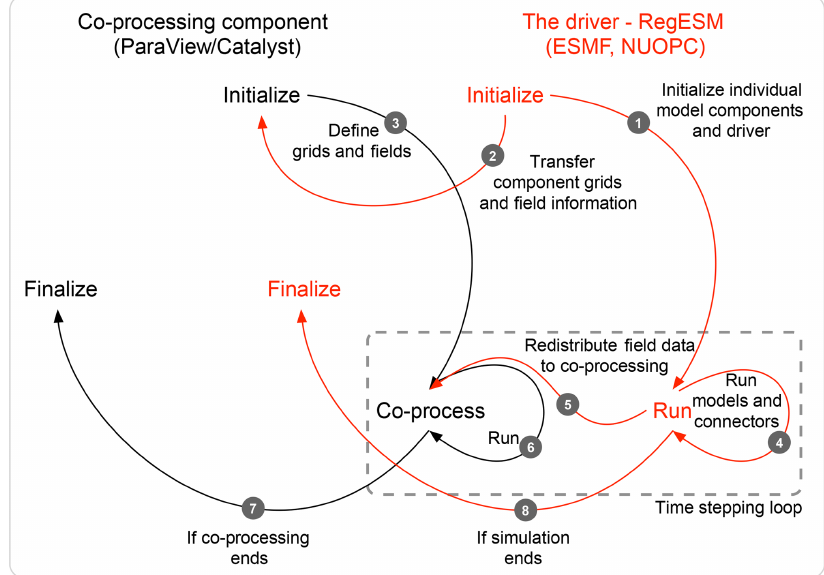
Figure 6. The interaction between the driver defined by ESMF/NUOPC and the co-processing component